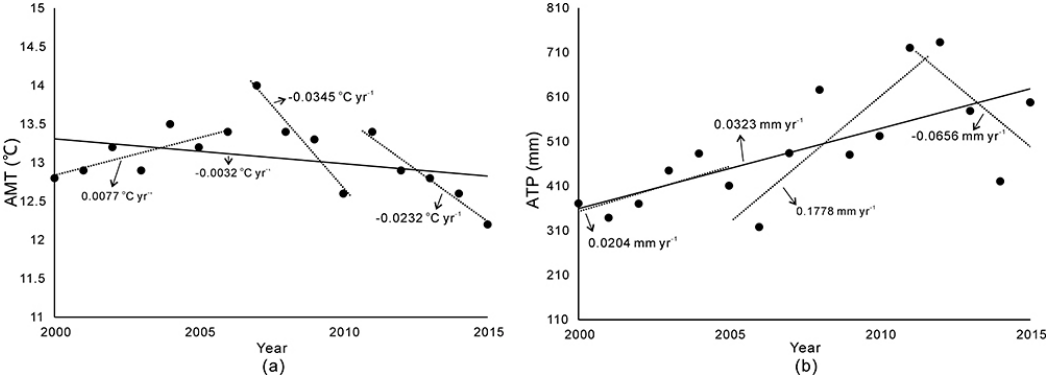
Figure 8. ( a ) AMT and ( b ) ATP in Beijing from 2000 to 2015.